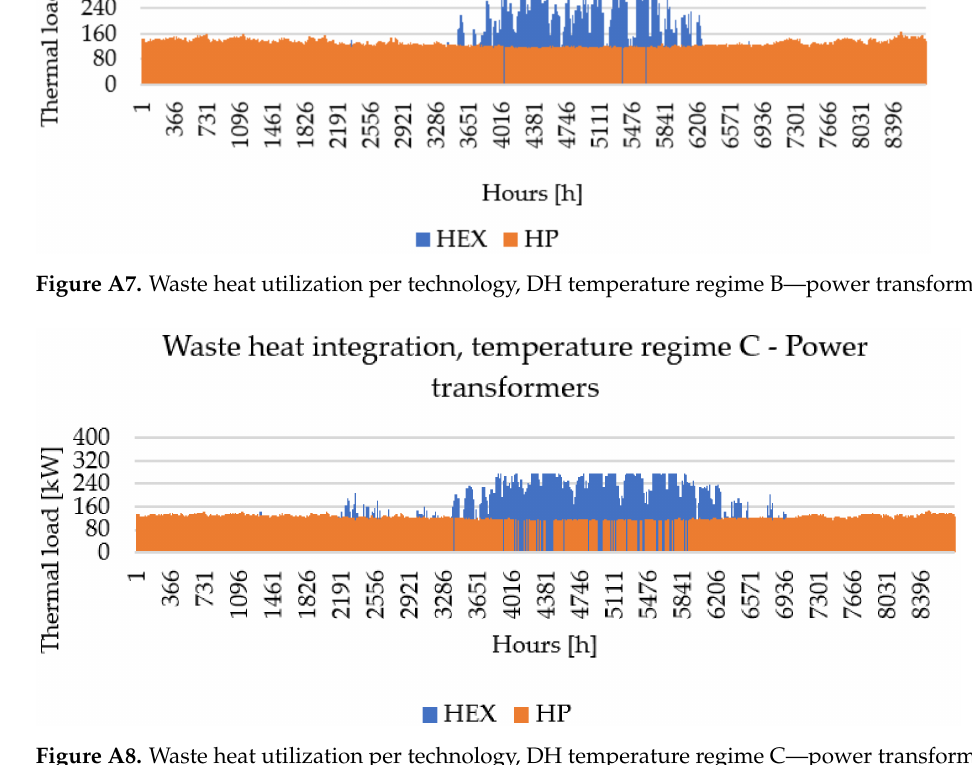
Figure A8. Waste heat utilization per technology, DH temperature regime C—power